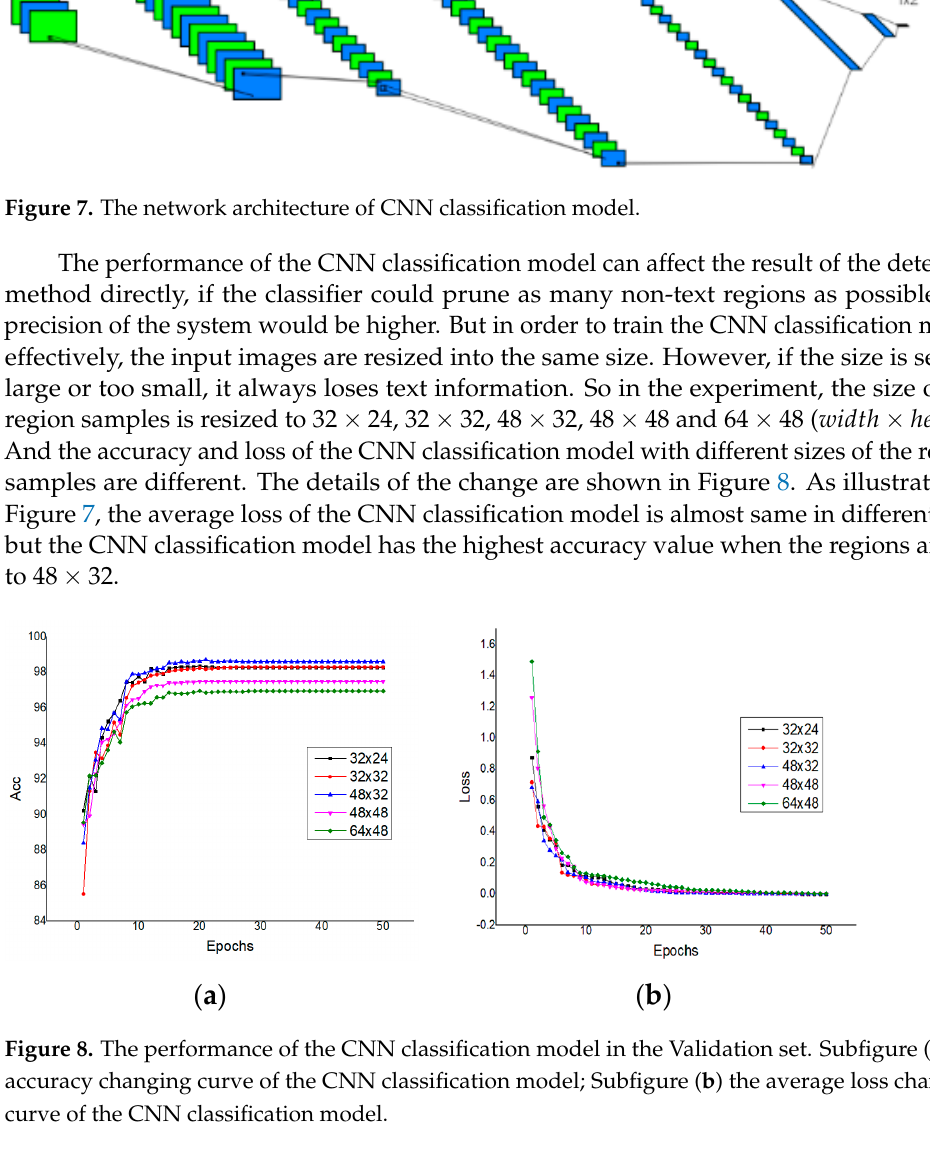
Figure 7. The network architecture of CNN classification model.